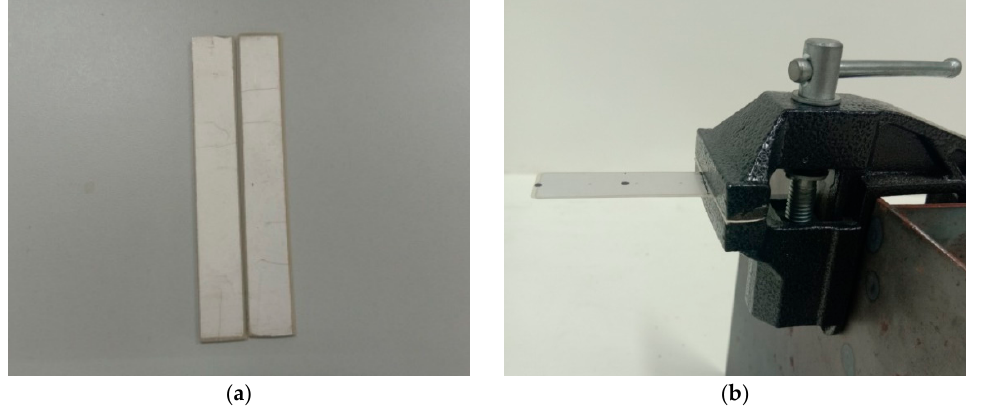
Figure 2. Scheme of the experimental specimens and piezoelectric cantilever beam: ( a ) PZT-5 piezoelectric ceramic specimens; ( b ) the piezoelectric cantilever beam. piezoelectric ceramic specimens; ( b ) the piezoelectric cantilever beam. Table 1. Physical properties of the PZT-5 materials [27].